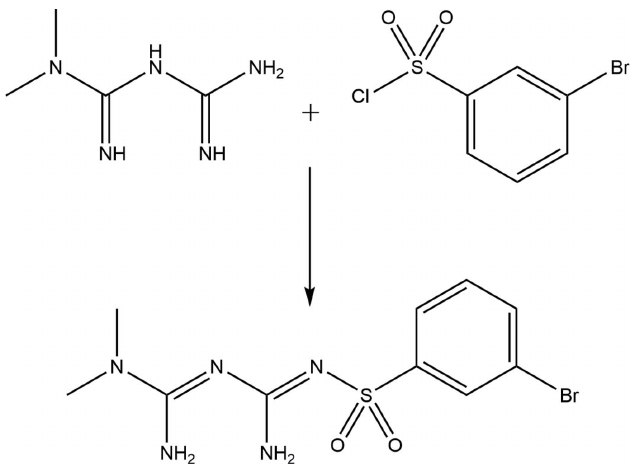
Figure 10 Reaction scheme for the synthesis of the title